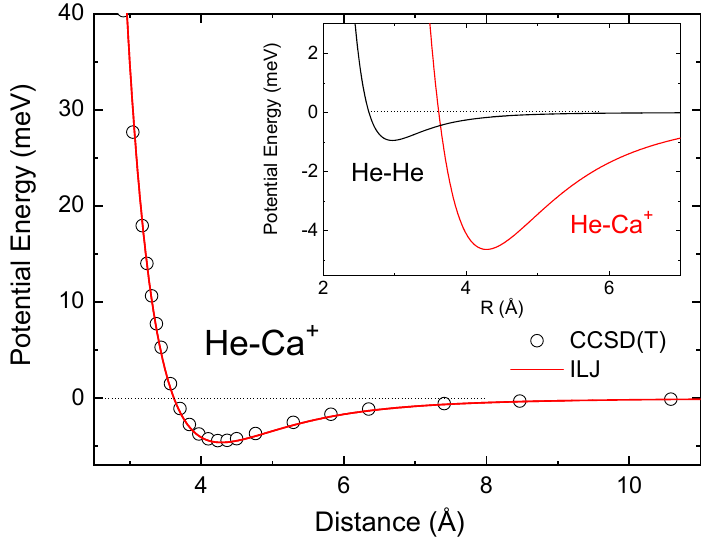
Figure 3. Potential energy curves for the He-Ca + interaction. Open black circles are CCSD(T) results and the red line depicts the analytical expression given by the ILJ potential of Equation (1). Inset: Comparison of the well regions of He-Ca + (red) and He-He [40] (black) interaction